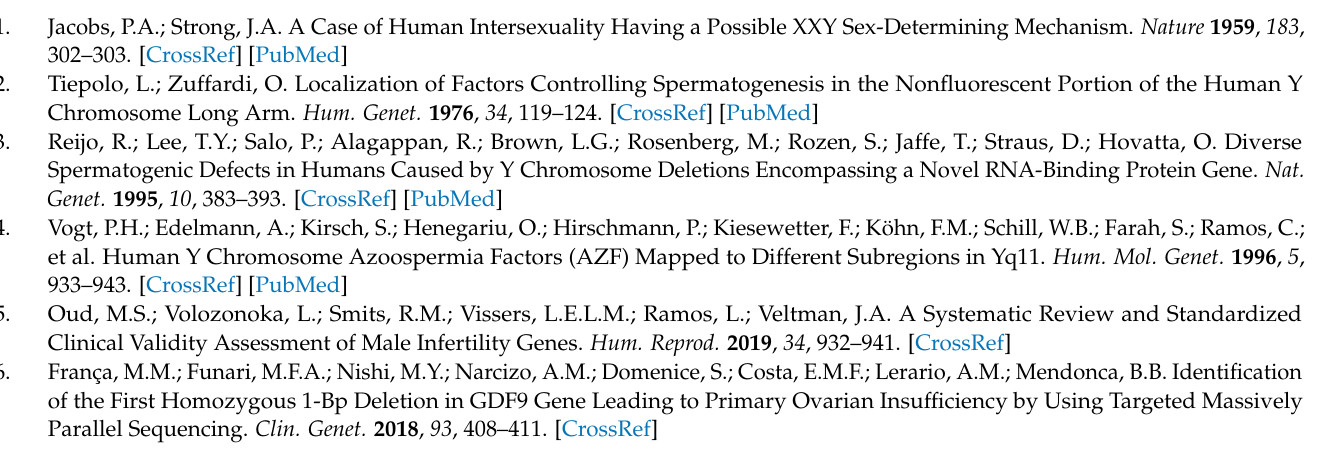
C5. Table S1: Primers used for amplification of ten candidate variants selected in 8 genes after panel analysis, Table S2: Sequencing quality for each gene from the infertility panel, Table S3: Sequencing quality and bioinformatics analysis information of the 94 patients, Table S4: Previously